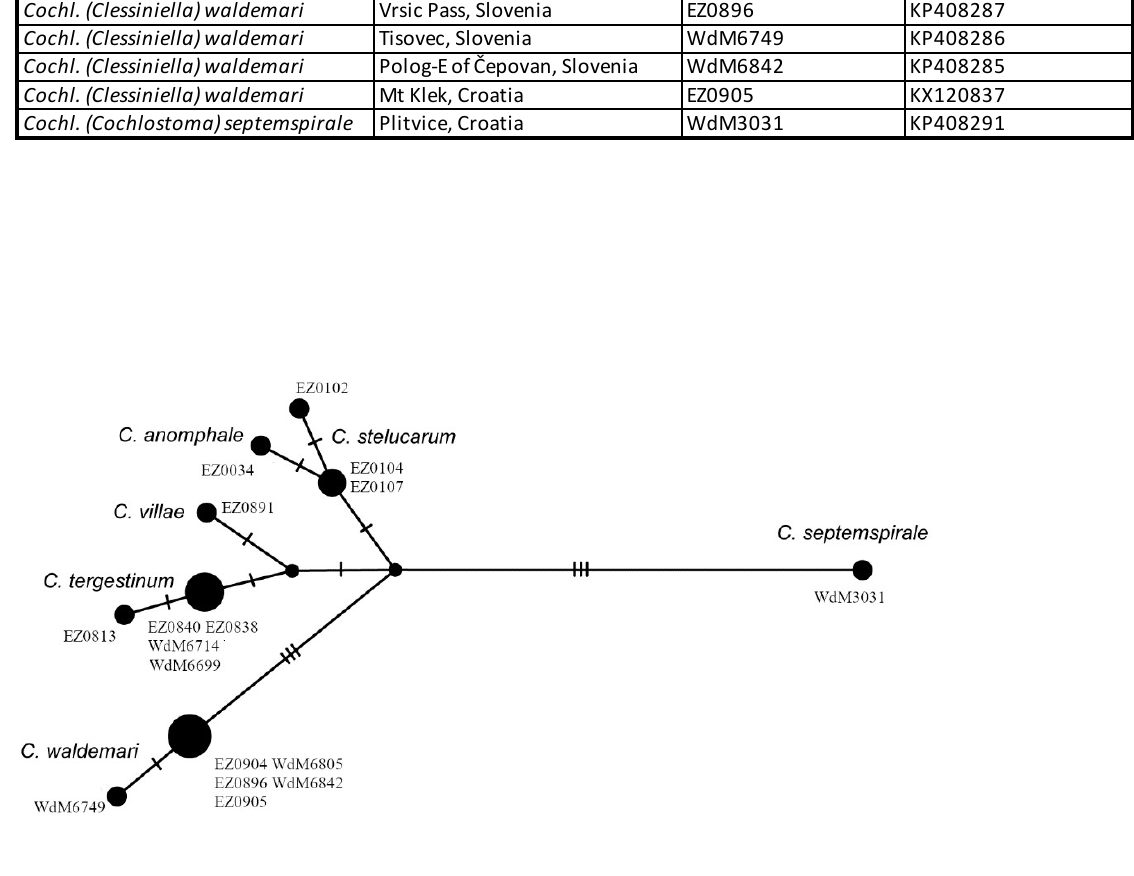
Fig. 7. Statistical parsimony network based on Histone H3 sequences of species in the subgenus Clessiniella Zallot et al ., 2015. Cochlostoma ( Cochlostoma ) septemspirale (Razoumowsky, 1789) was used as an outgroup. For sample IDs we refer to Table